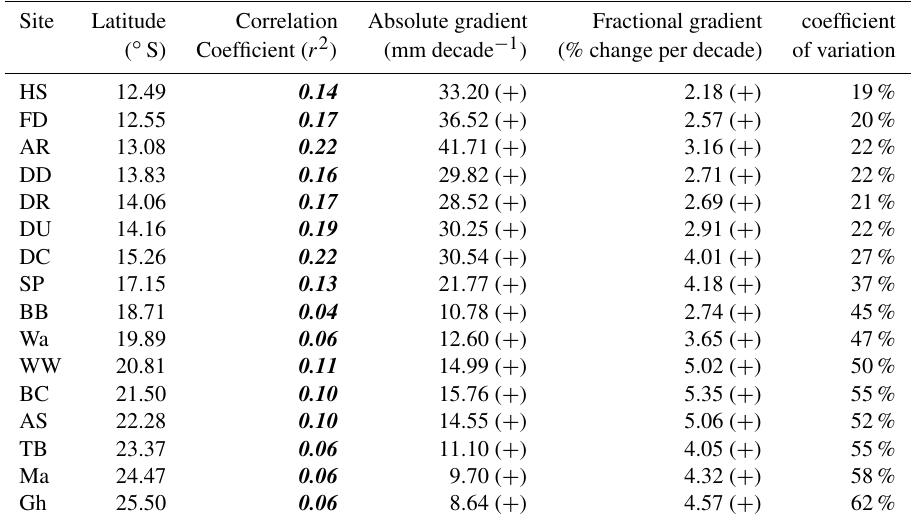
Table 3. Temporal rainfall trends using linear regression of annual data along the NATT for the period 1900 to 2010. Italicised and bold r 2 values are significant at the 95% significance level (i.e. all trends are significant). Strength shows the goodness of fit of the linear trend line. Absolute gradient shows the actual increase in annual rainfall per decade. Fractional gradient shows the increase in annual rainfall per decade of a site relative to the mean rainfall at that site. Brackets indicate the sign of the linear trend if significant. Coefficient of variation shows the variability of each site as a percentage of the sites annual average